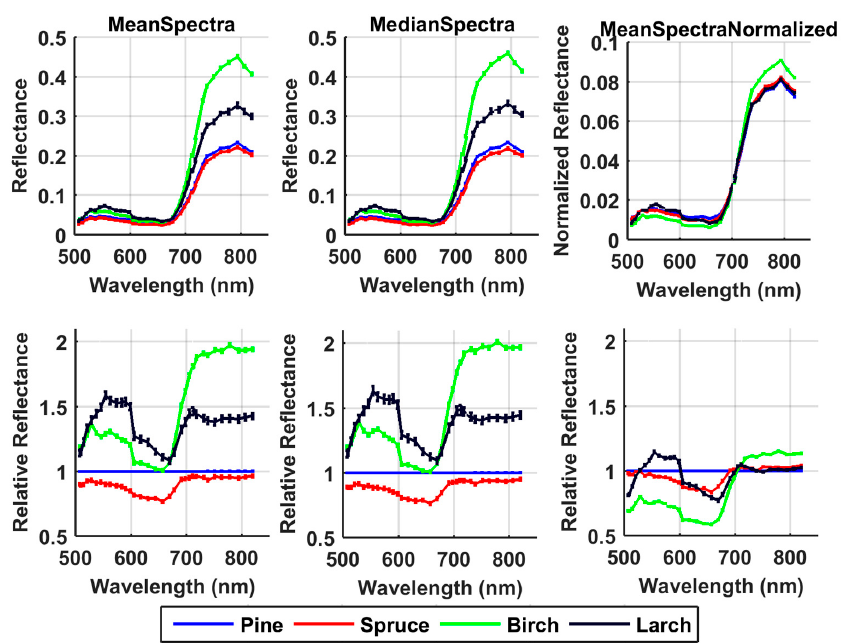
Figure 8. Mean, Median and MeanNormalized spectra of different species averaged over all test sites (top row) and the same spectra normalized to Pine spectra (bottom row). Test sites with less than 10 tree samples have been omitted from the plot. The error bars present the standard error.